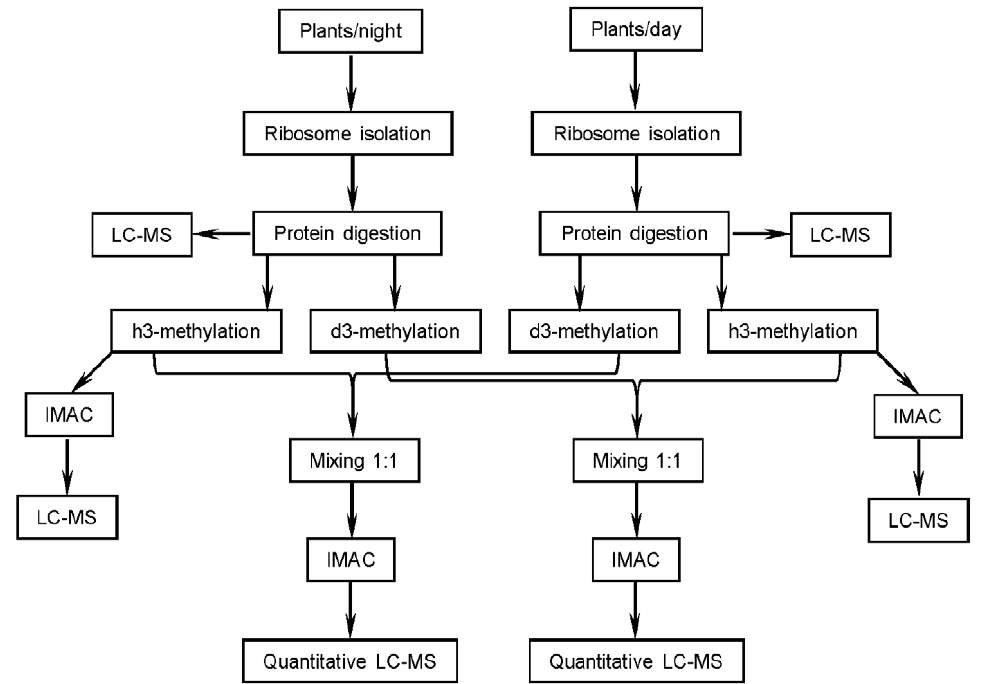
Figure 1. A scheme for preparation and analyses of ribosomal proteins from leaves of Arabisopsisthaliana harvested during day or night. S6-1 and s 237 RLs 240 SAPAKPVAA from the 40S ribosomal protein S6-2 (Table 1). Additionally we identified 40S ribosomal protein S6 phosphorylation at Ser-231, which has not been previously characterized.